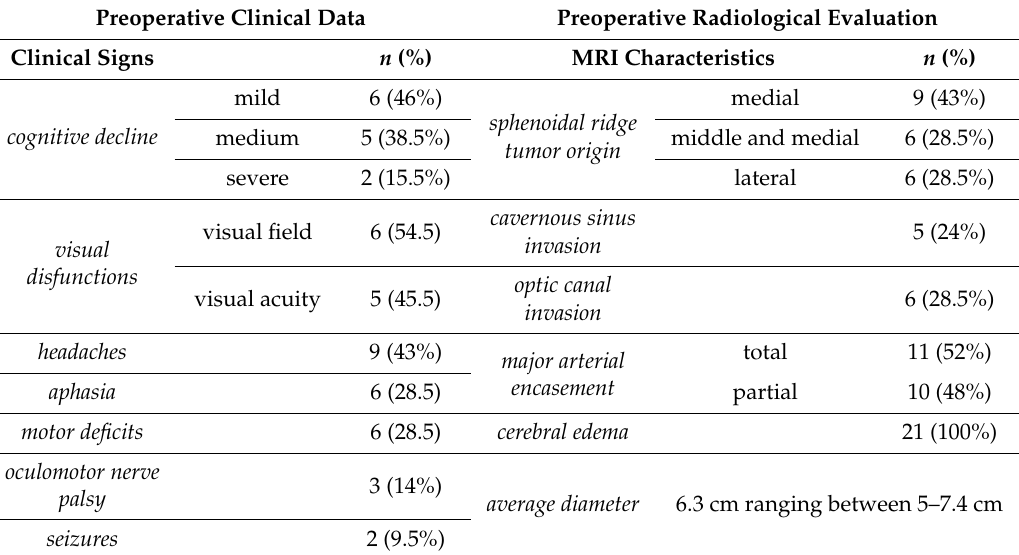
Table 1. Preoperative clinical and radiological